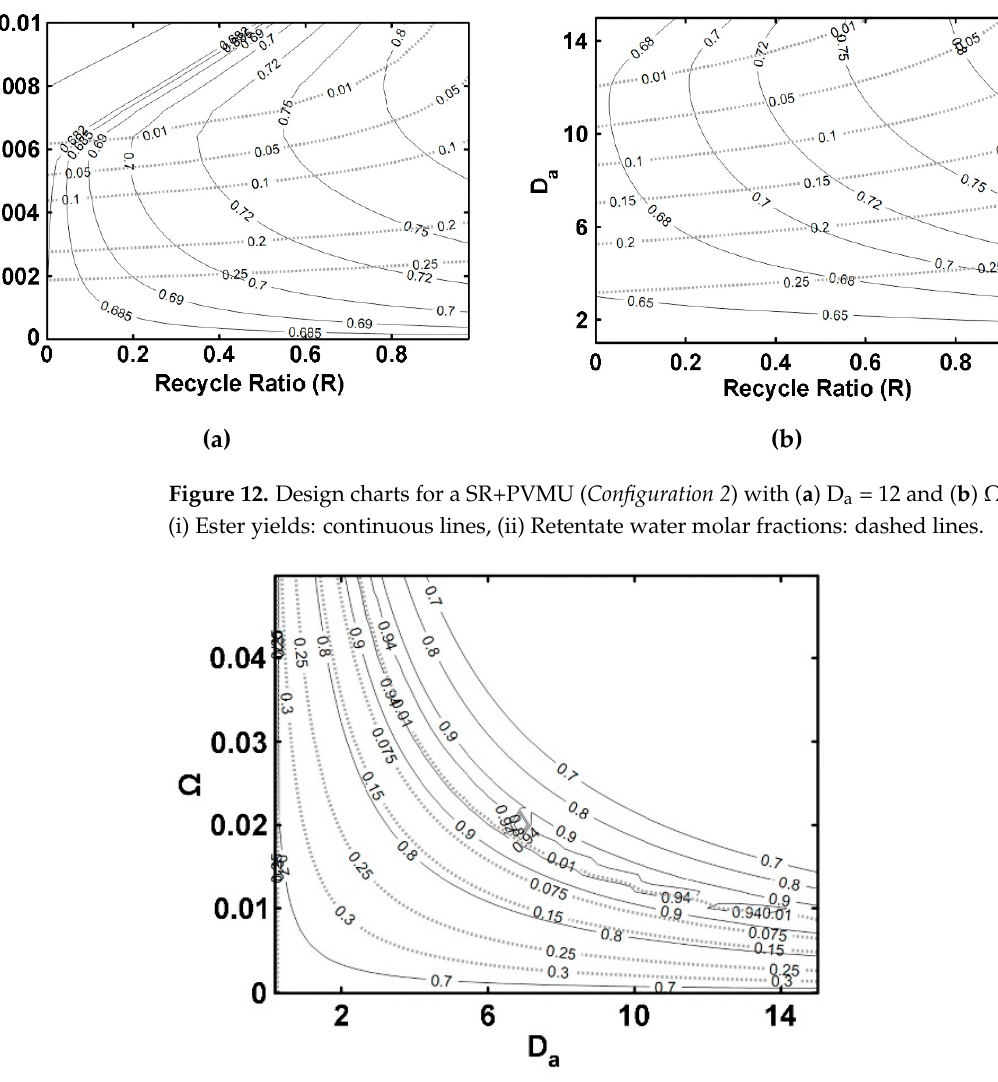
Figure 11. FBR+PVMU ( Configuration 1 ) simulation charts: ( a ) D a = 12 (left side), ( b ) Ω = 0.008. Notes: (i) Ester yields: continuous lines, (ii) Retentate water molar fractions: dashed lines.